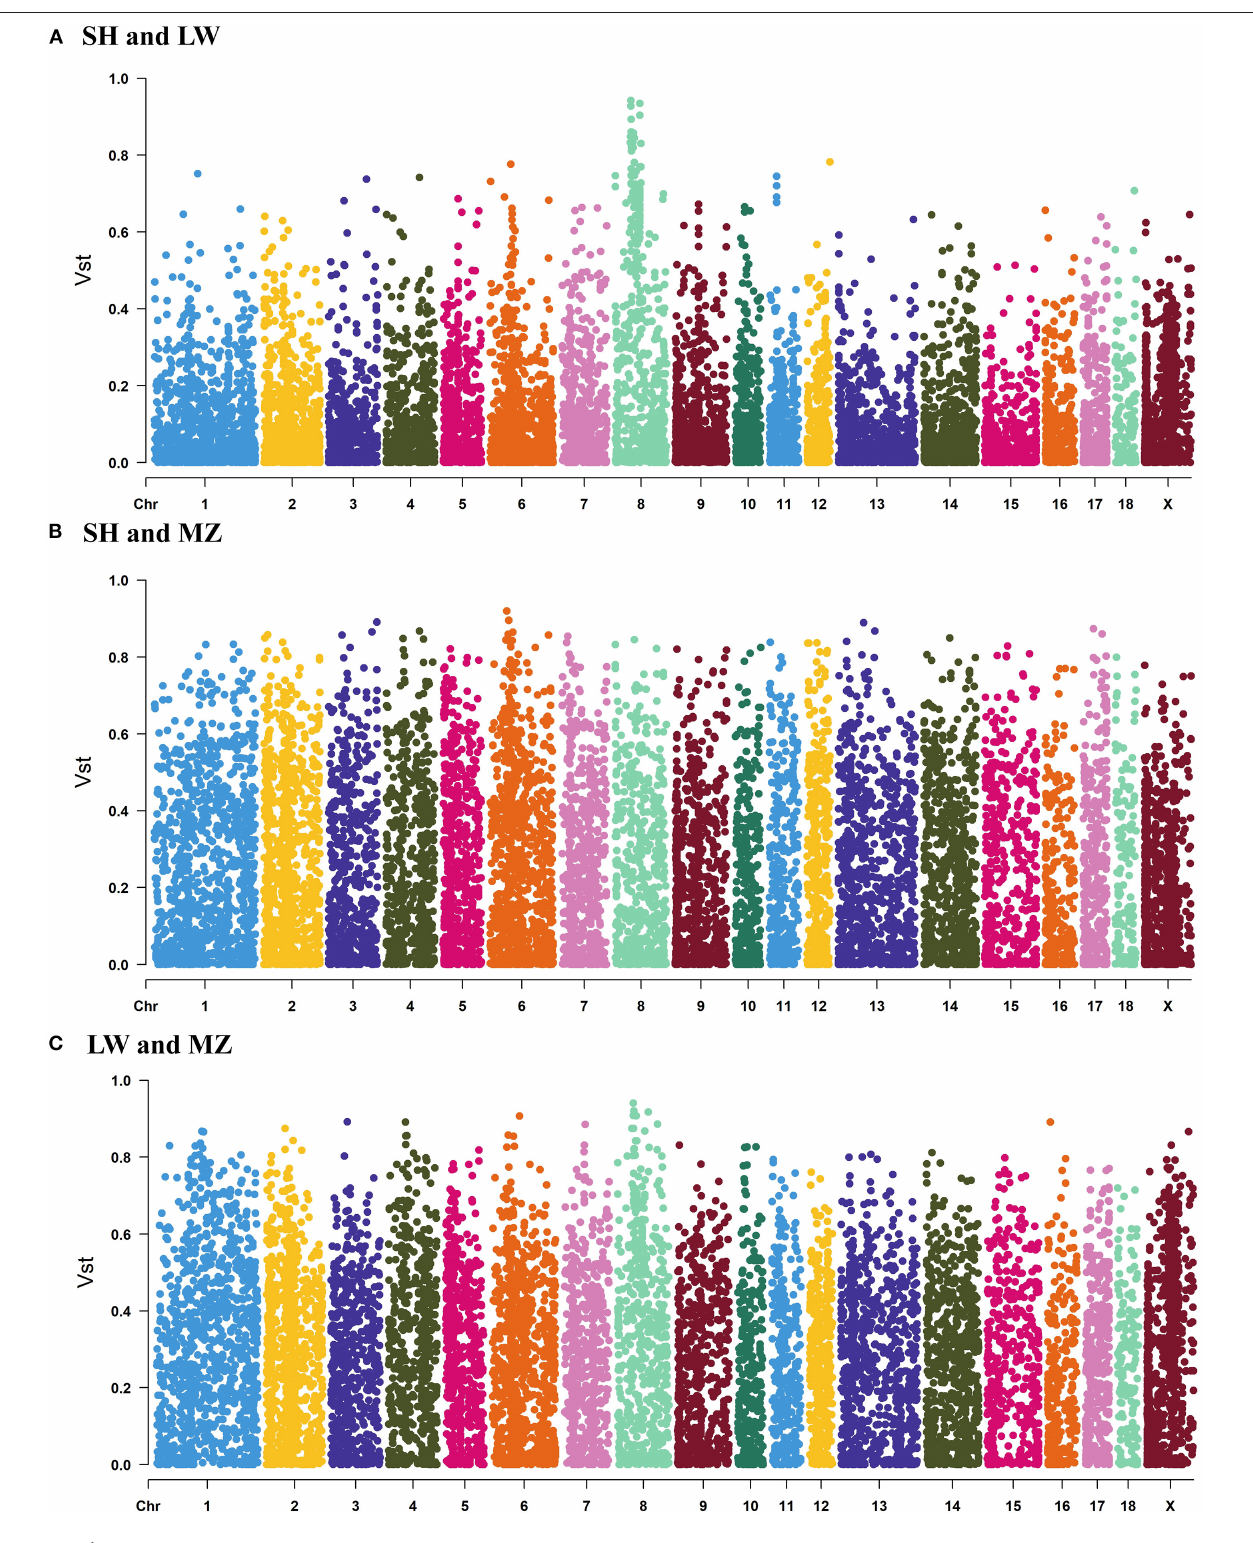
FIGURE 3 | The V ST values of all the copy number variation regions (CNVRs) in SH and LW (A) pigs, SH and MZ (B) pigs, LW and MZ (C) pigs. The average VST value of SH and LW pigs is just 0.111; but the average VST values are 0.234 and 0.265 in SH and MZ pigs and LW and MZ pigs, respectively.